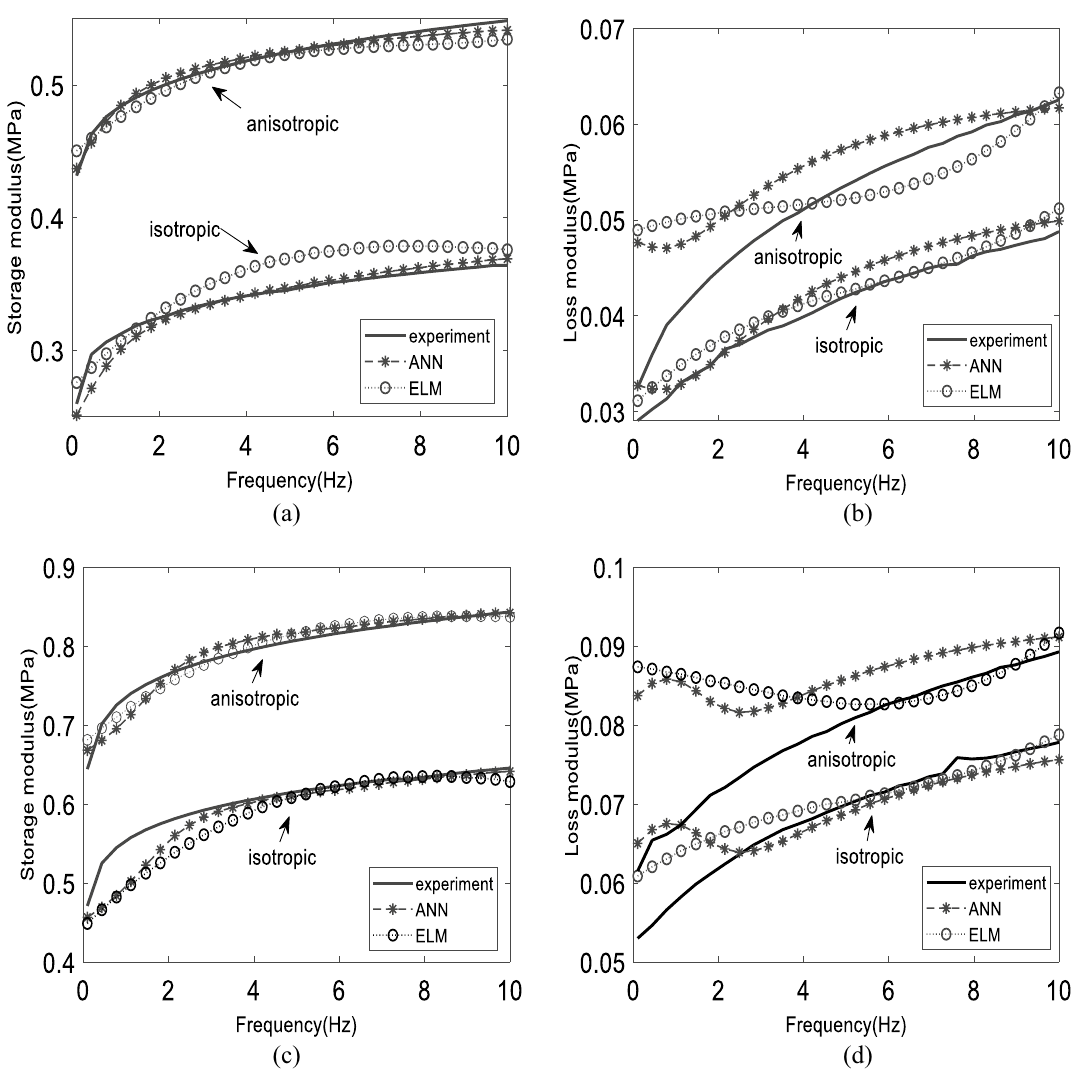
Figure 4. The comparison of dynamic moduli between experimental, ANN, and ELM model on 0.69 T: ( a ), ( b ) for learned 60% CIP, ( c ), ( d ) for learned 70% CIP on both